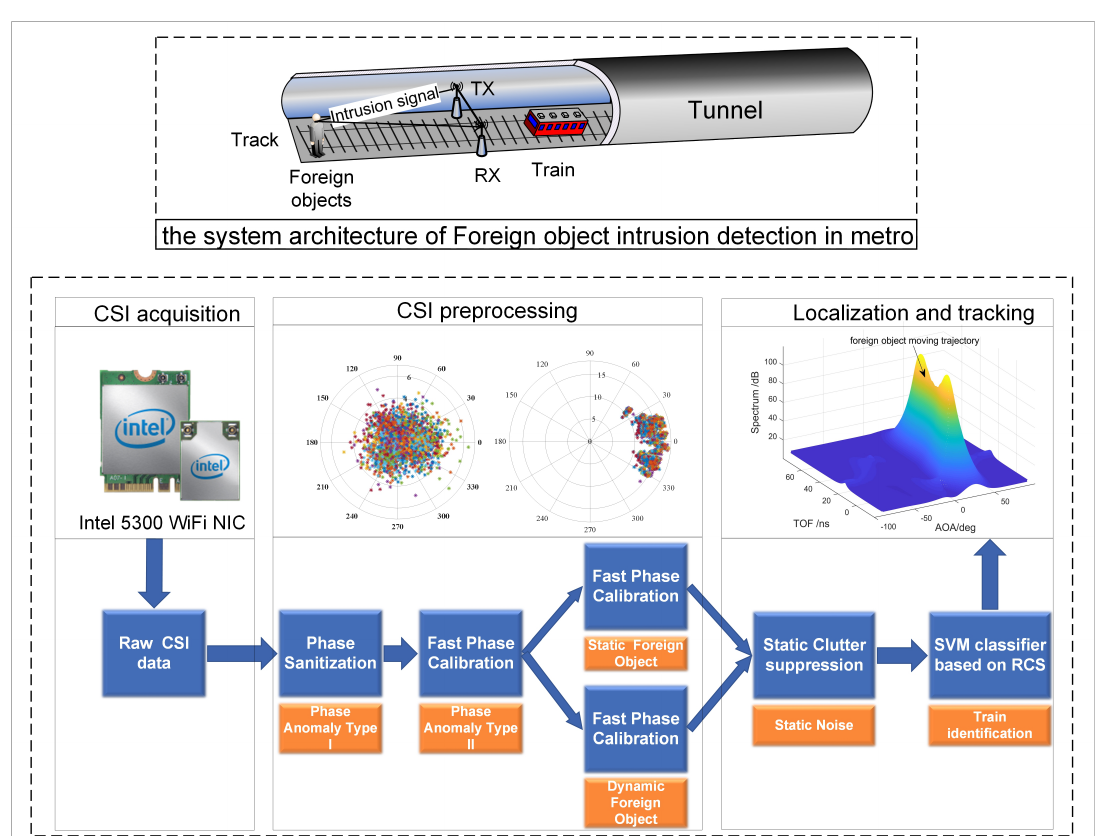
Figure 1. System architecture of foreign object intrusion detection in